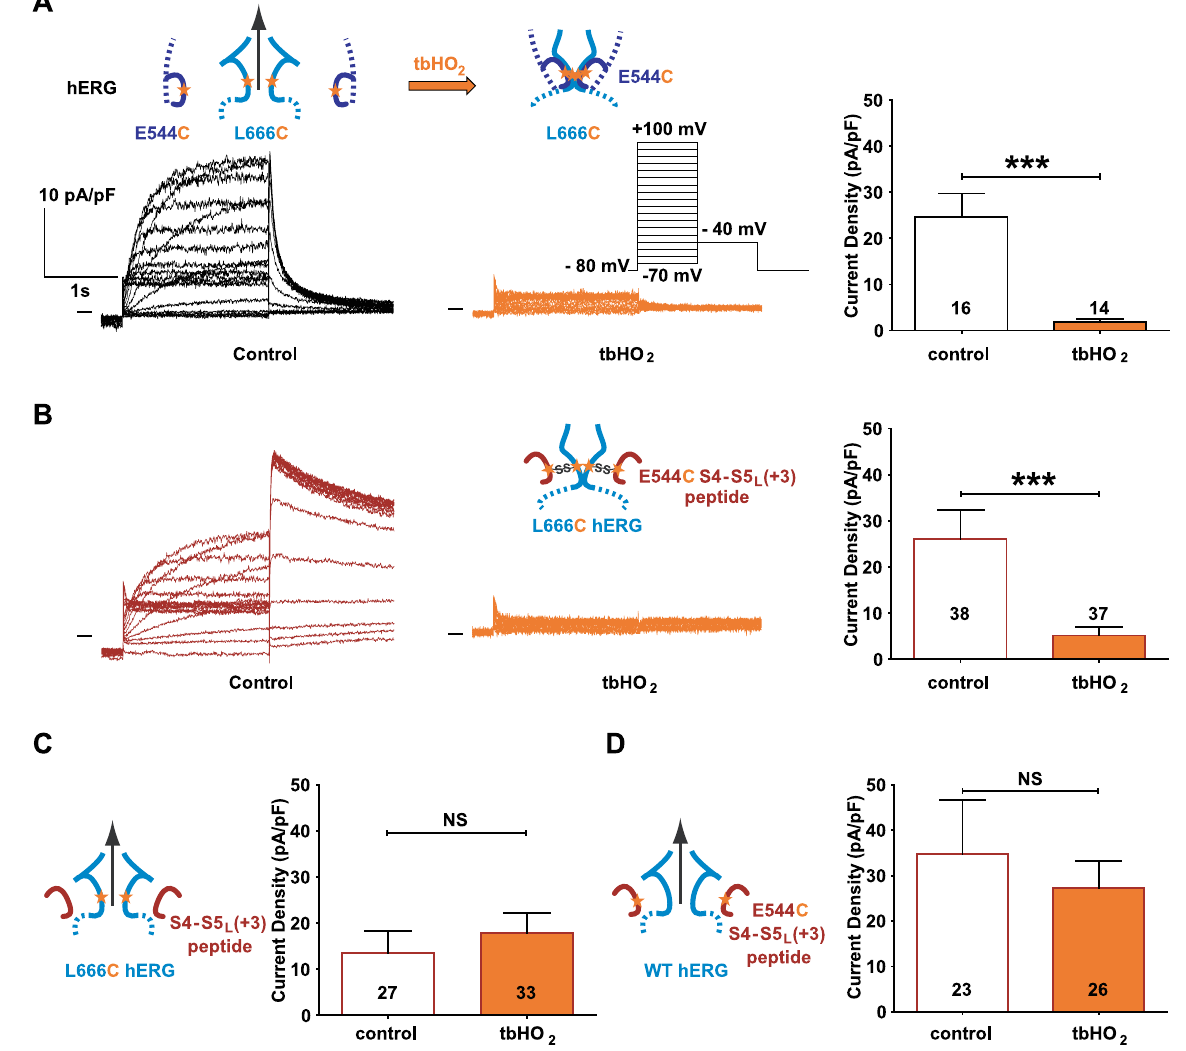
E544C-L666C hERG plasmid plus 0.4 µ g GFP plasmids) and right, mean tail-current density at − 40 mV after a prepulse at + 100 mV after 2 h incubation in Tyrode without (control) or with 0.2 mM tbHO 2 (tbHO 2 ), both using the voltage protocol shown in inset. ( B ) left, representative, superimposed recordings of the single mutant L666C hERG current in the presence of E544C S4-S5 L ( + 3) peptide (1 µ g L666C hERG plus 3 µ g peptide plasmids) and right, mean tail-current density measured in the same conditions as A. ( C , D ) Mean tail-current density in the presence of only one cysteine, i . e . L666C hERG + S4-S5 L ( + 3) peptide ( C ) or WT hERG + E544C S4-S5 L ( + 3) peptide ( D ). *** p < 0.001 versus control, Mann-Whitney